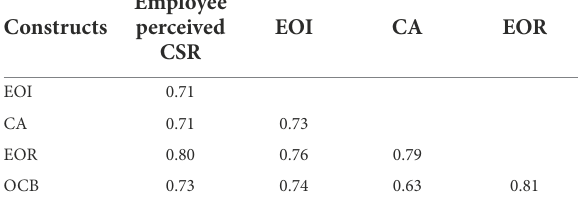
TABLE 1 The correlation matrix of variables.